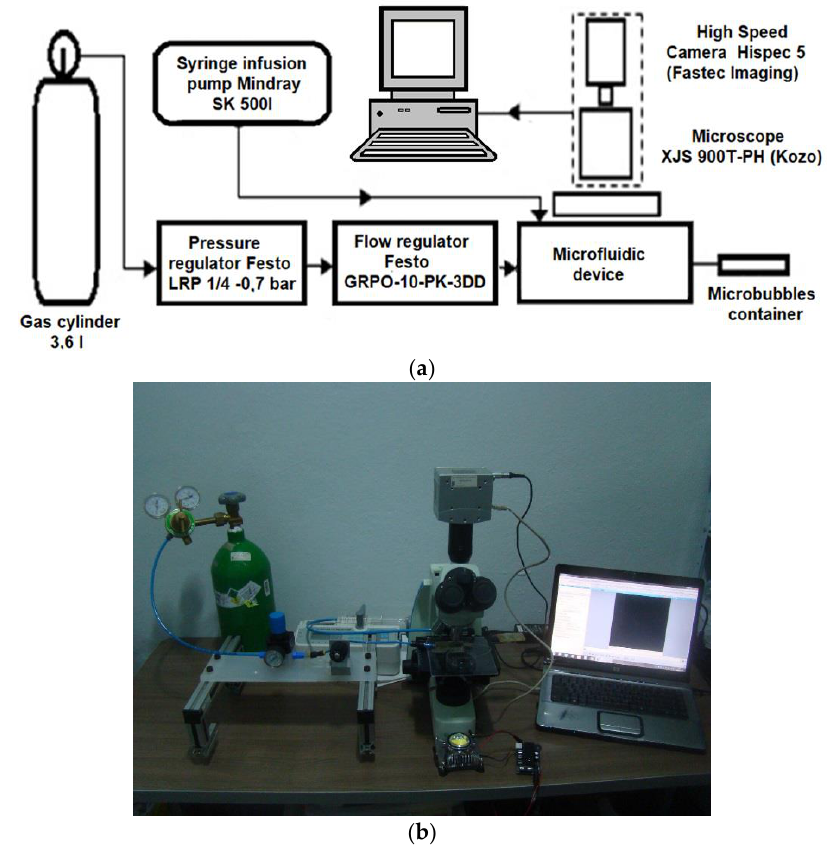
Figure 2. ( a ) Diagram of the experimental apparatus used in the generation of microbubbles. ( b ) A picture of the actual experimental setup.